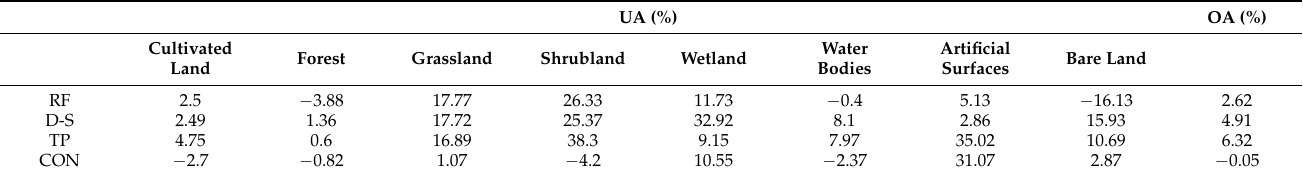
Table 5. Accuracy gains in different fusion products, 2010.